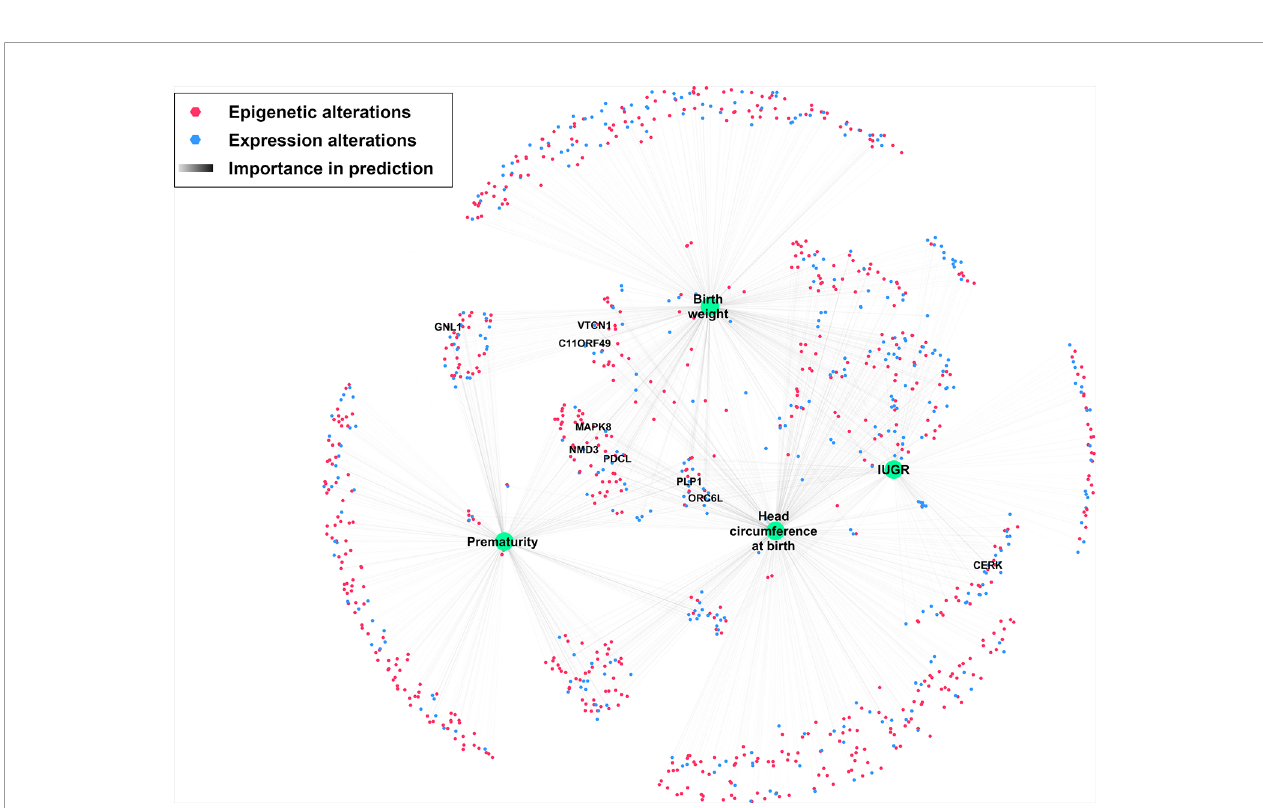
FIGURE 7 | Network depicting signi fi cantly altered features and their importance in predicting IUGR phenotype. Nodes were positioned according to an Edge- weighted Spring Embedded Layout, based on feature importance for predicting each phenotypic trait. Only genes with at least 80% importance for predicting at least one phenotypic trait are